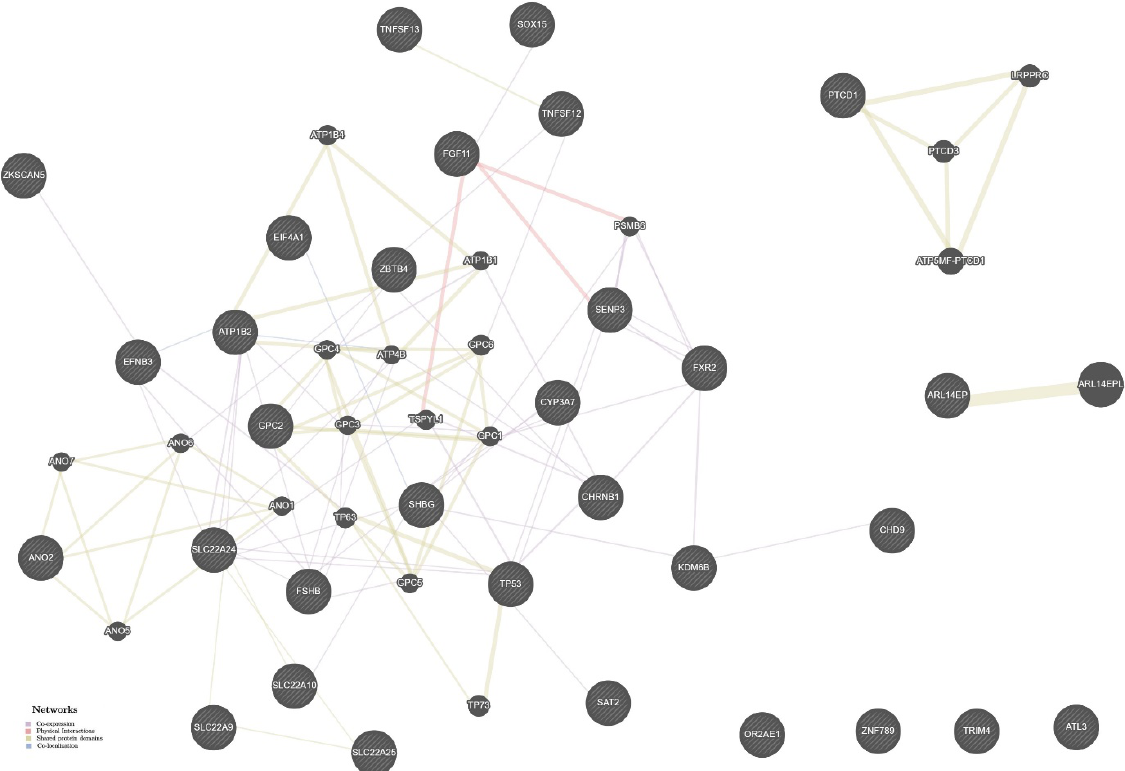
Figure 3. The interaction networks of the candidate genes for endometriosis in various tissues/organs inferred using GeneMANIA (http://genemania.org (accessed on 15 July 2022)). The candidate genes are cross-shaded.